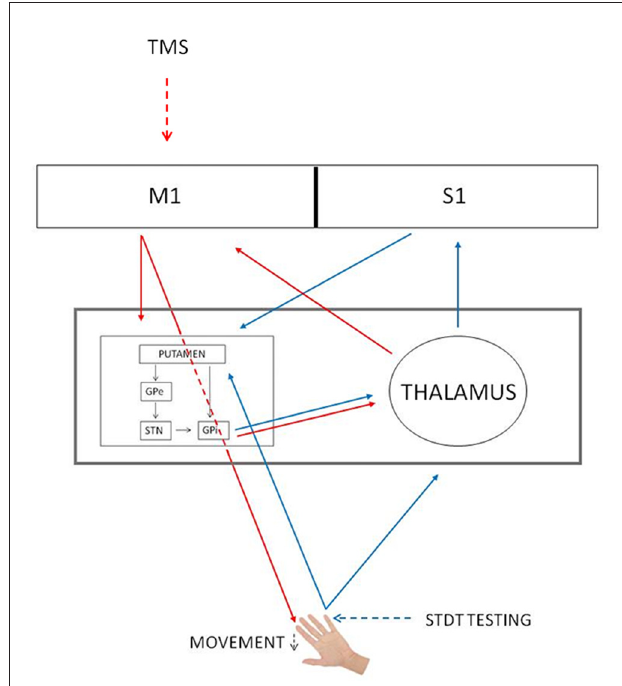
FIGURE 4 | mSI and STDT gating circuits. Red arrows, mSI circuit. Blue arrows, STDT gating circuit. Black arrows, basal ganglia circuits. The gray rectangle shows that basal ganglia and thalamus underlie both mechanisms. GPe, globus pallidus externus; GPi, globus pallidus internus; M1, primary motor cortex; S1, primary somatosensory cortex; STN, subthalamic nucleus; TMS, transcranial magnetic stimulation. increase motor performance accuracy at the onset of movement ( Figure 4